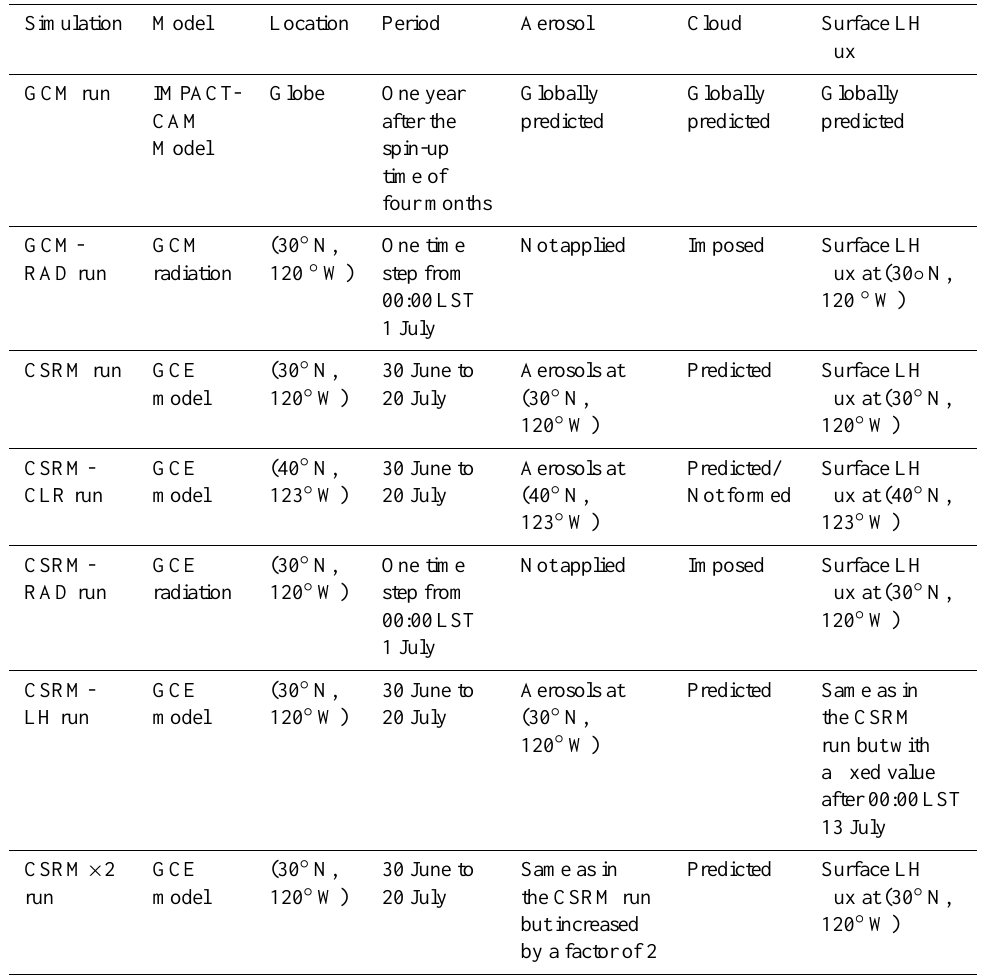
Table 1. Summary of